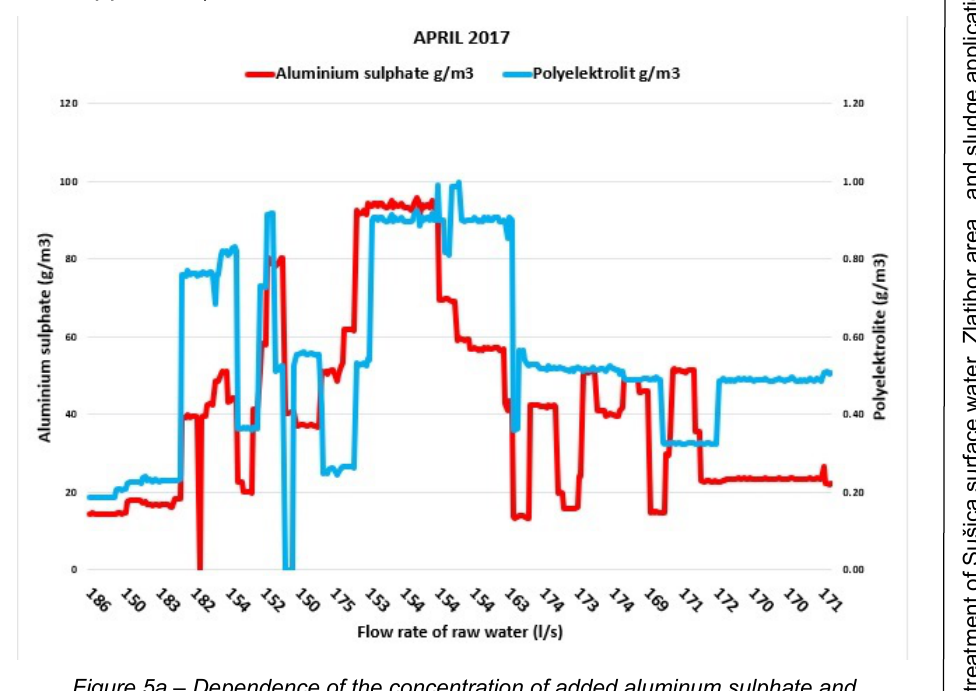
Figure 5a – Dependence of the concentration of added aluminum sulphate and polyelectrolyte on the flow rate of raw water during April 2017 Рис . 5a – Взаимозависимость концентрации добавленного сульфата алюминия